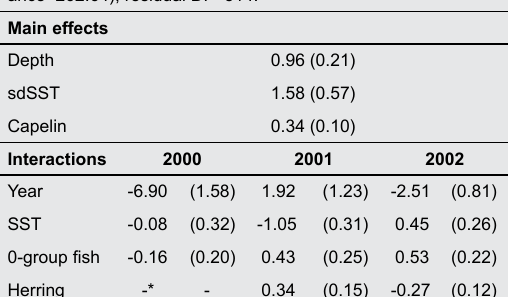
Table 6. Estimates (and SE) of variables in selected model describing fin whale distributions within the fin whale core area in 2000, 2001 and 2002. Residual deviance=189.17 (Null devi- ance=262.64), residual DF=314.